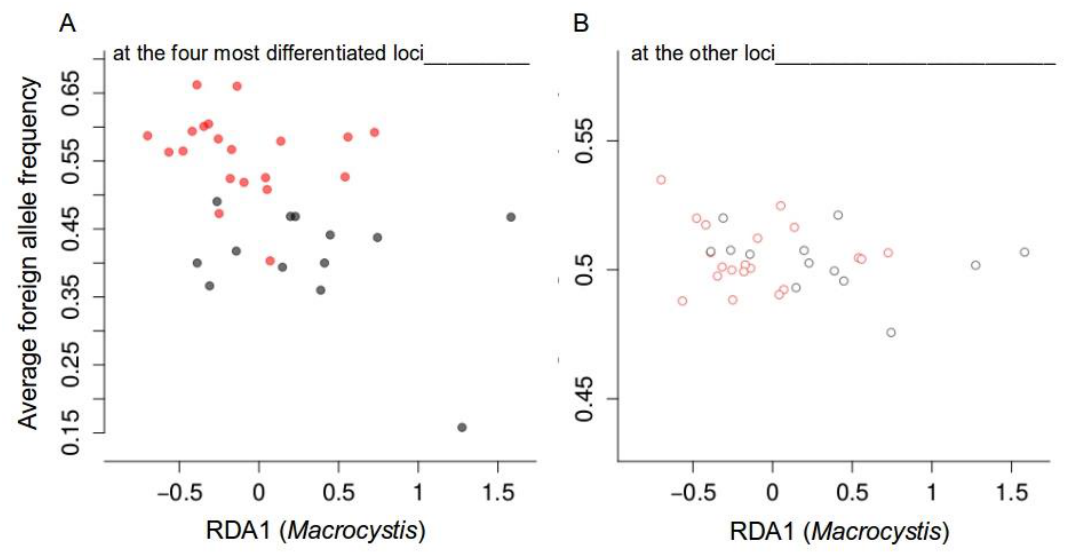
Figure 5. Correlation between the average foreign allele frequency of the four most differentiated loci ( A ) and other loci ( B ) at each sampling site in the Kerguelen Islands (y-axis, Table S4), and the presence/absence of Macrocystis (x-axis, this is the average sampling site coordinates on the first axis of the Macrocystis RDA, see Table S12). Pearson correlation coefficient: on the left panel, 0.494 (p-value=0.003); on the right panel, 0.107 (p-value=0.541). Red points indicate sites located in the Gulf of Morbihan (see Figure